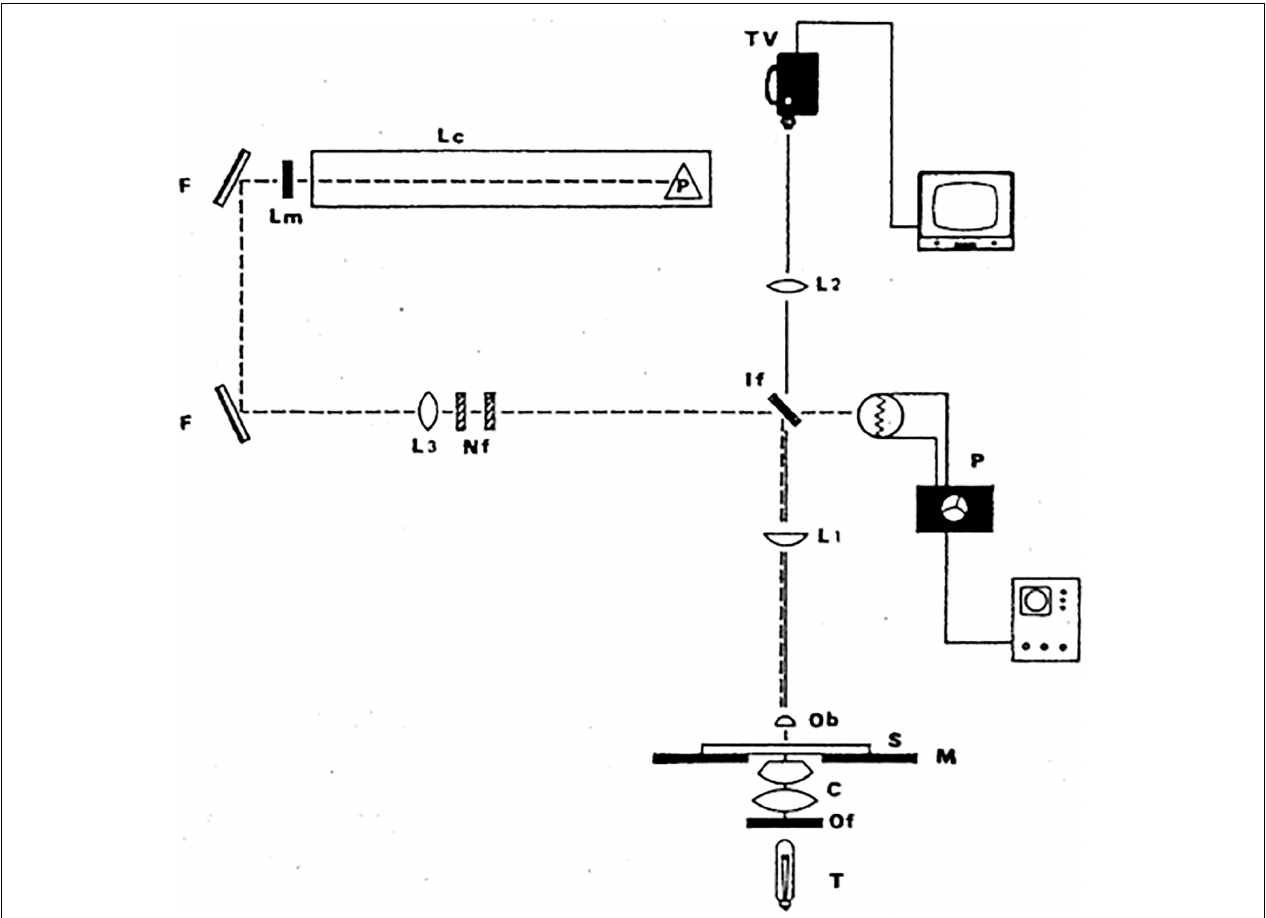
FIGURE 2 | Simple and versatile argon ion laser microscope. Either of the two microsecond-pulsed 514 and 488 nm beams is passed into an upright Zeiss phase contrast microscope. It reflects 90 degrees off a dichroic interference filter (IF) that reflects the blue-green wavelengths into the microscope but transmits longer wavelengths to the video camera. The phase contrast objective (Ob) (100 × or 63 × ; 1.4–1.3 na) focuses the beam to a diffraction-limited spot (0.4–0.5 µ m) inside the target cell. Lc, laser cavity; Lm, laser output mirror; F, front surfaced reflecting mirrors; Nf, neutral density filter; If, dichroic interference filter; L1 and L2, lenses; P, photomultiplier dosimetry device; T, tungsten light source; c, condenser; Of, optical heat filter; M, microscope; S, microscope stage; TV, analog television camera (after Berns, 1971,